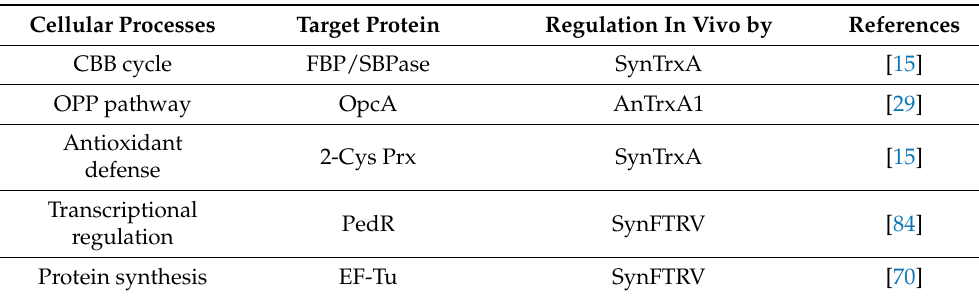
Table 2. Trx target proteins described in vivo. Proteins are indicated with abbreviations for the name of the organism: Synechocystis TrxA (SynTrxA), Anabaena TrxA1